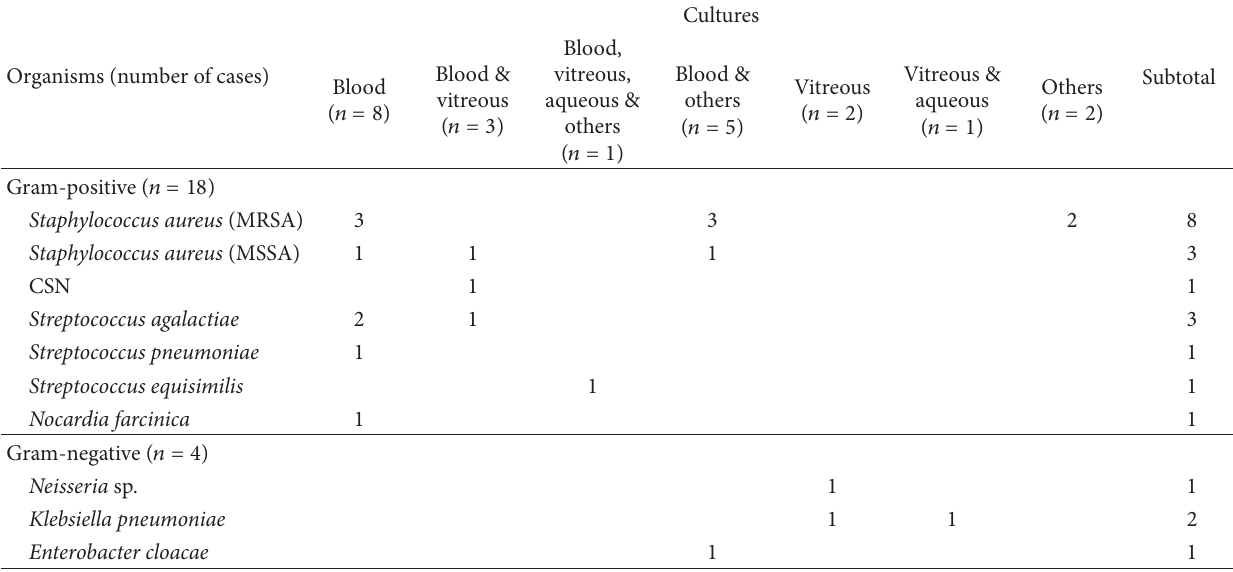
Table 3: Isolated organism from blood, intraocular, or other